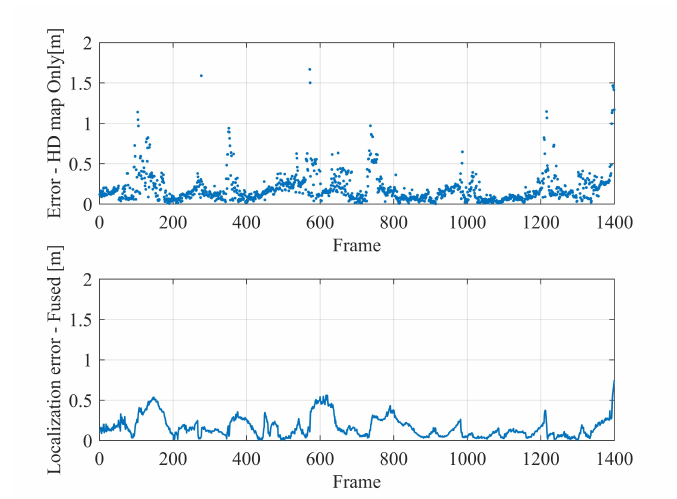
Figure 16. Vehicle localization results in the scenario 1—top: positioning errors of map-based localization; bottom: translation errors after fusing frame-to-frame constraints.